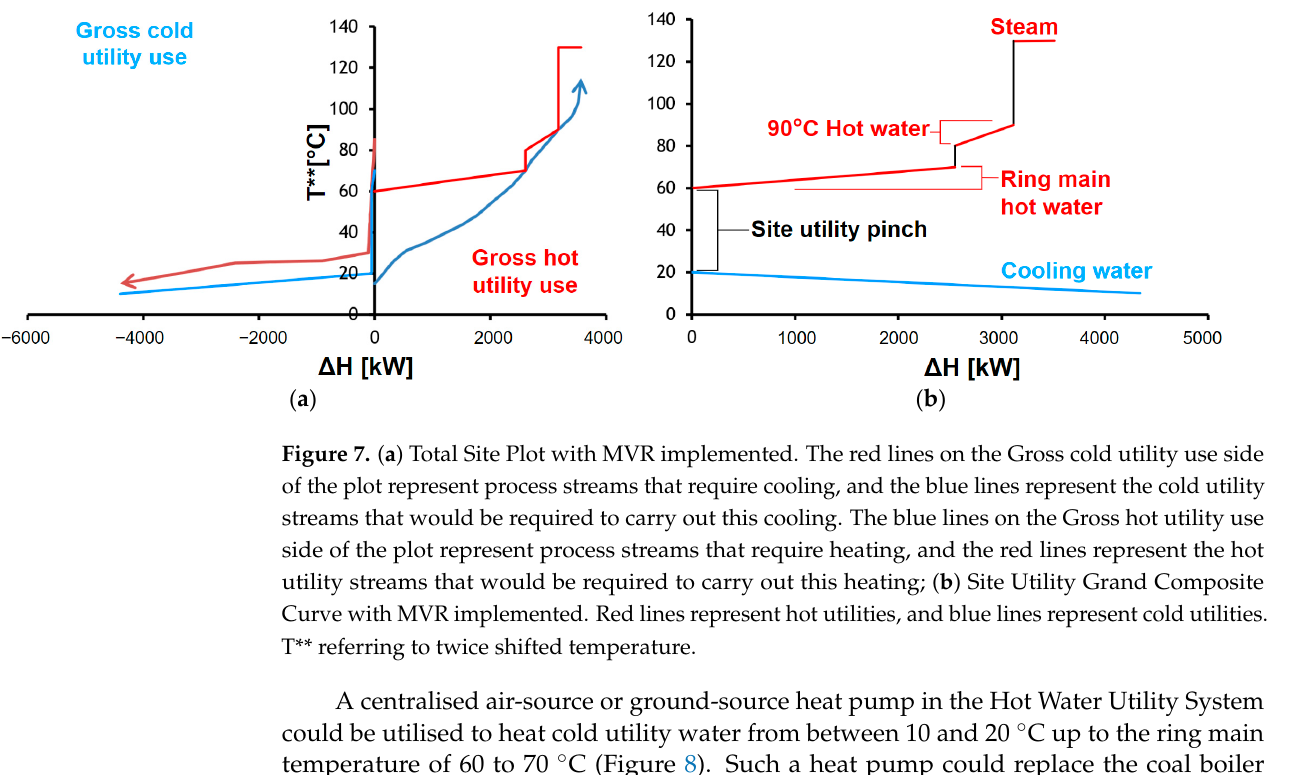
T** referring to twice shifted temperature.